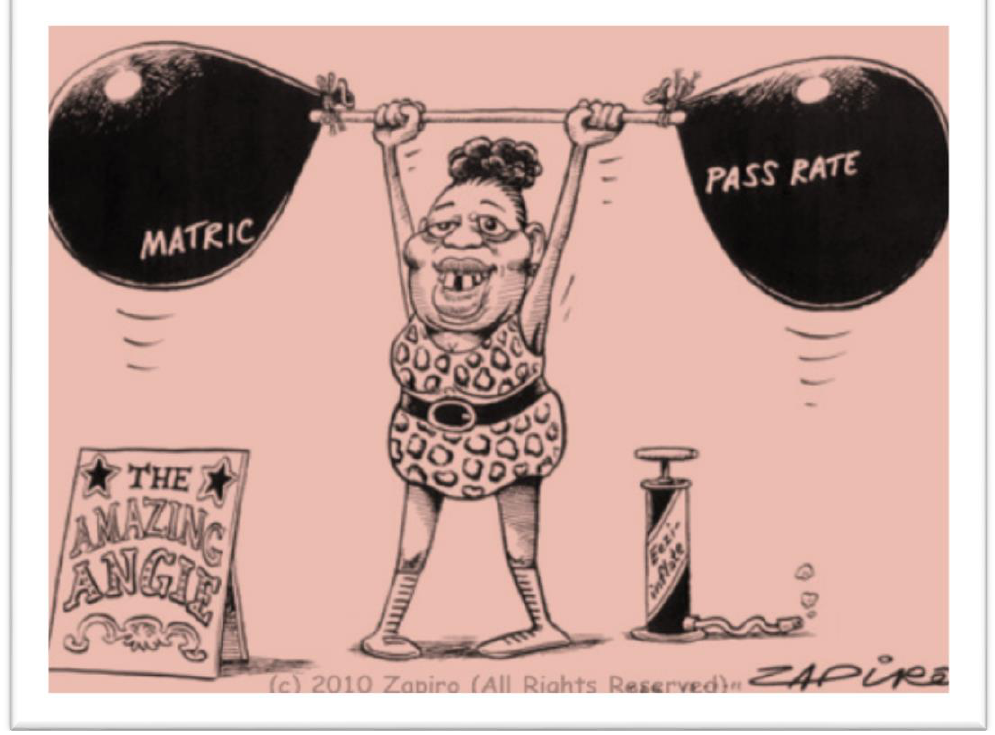
Figure 1 . Cartoon A: Showing “THE AMAZING ANGIE: MATRIC PASS RATES”